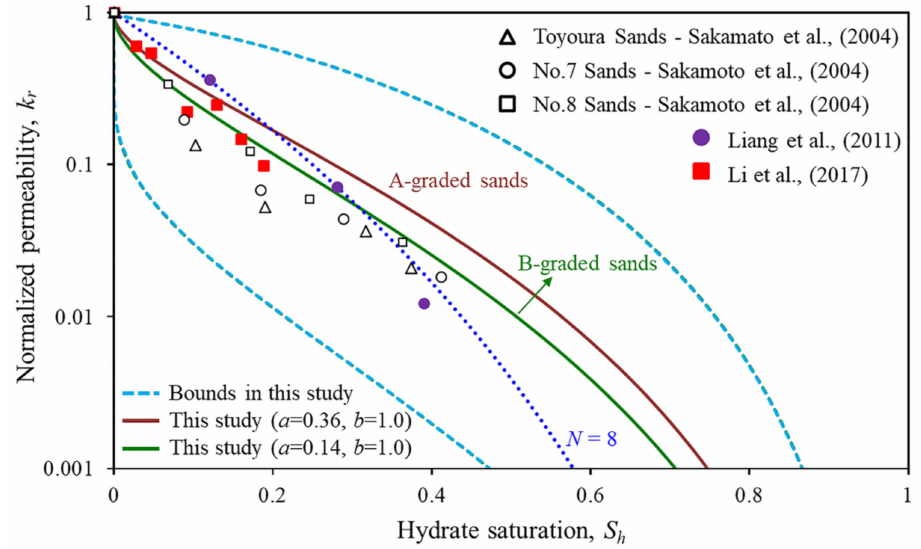
Figure 19. Comparison of prediction results from fractal-based models and reported experimental data [55,95,99]. Reprinted with permission from Ref. [61]. Copyright 2022 American Geophysi- cal Union.